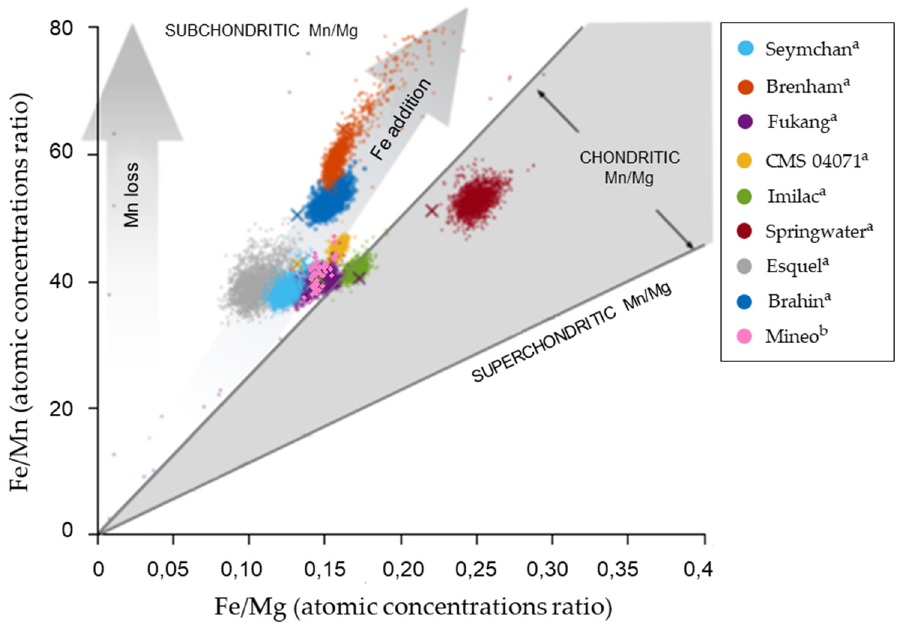
Figure 7. Fe/Mg-Fe/Mn pallasite olivines plot. The picture is modified after Chernonozhkin et al. 2021. Chernonozhkin et al. 2021 [57] a Zucchini et al. 2018 [41] b .